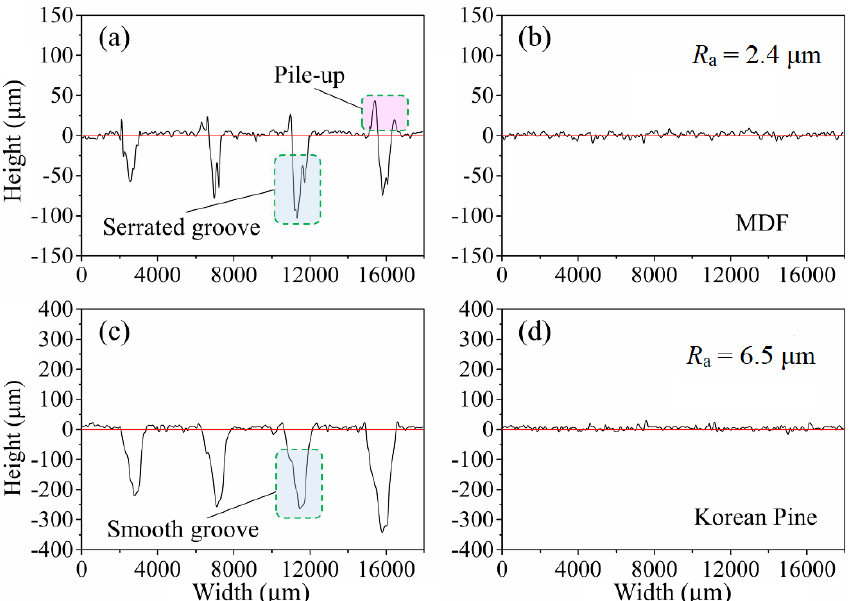
Figure 5. The cross-sectional profiles of scratched surface and original surface: ( a ) the scratched surface of MDF; ( b ) the original surface of MDF; ( c ) the scratched surface of Korean Pine ( λ = 0 ◦ ); ( d ) the original surface of Korean